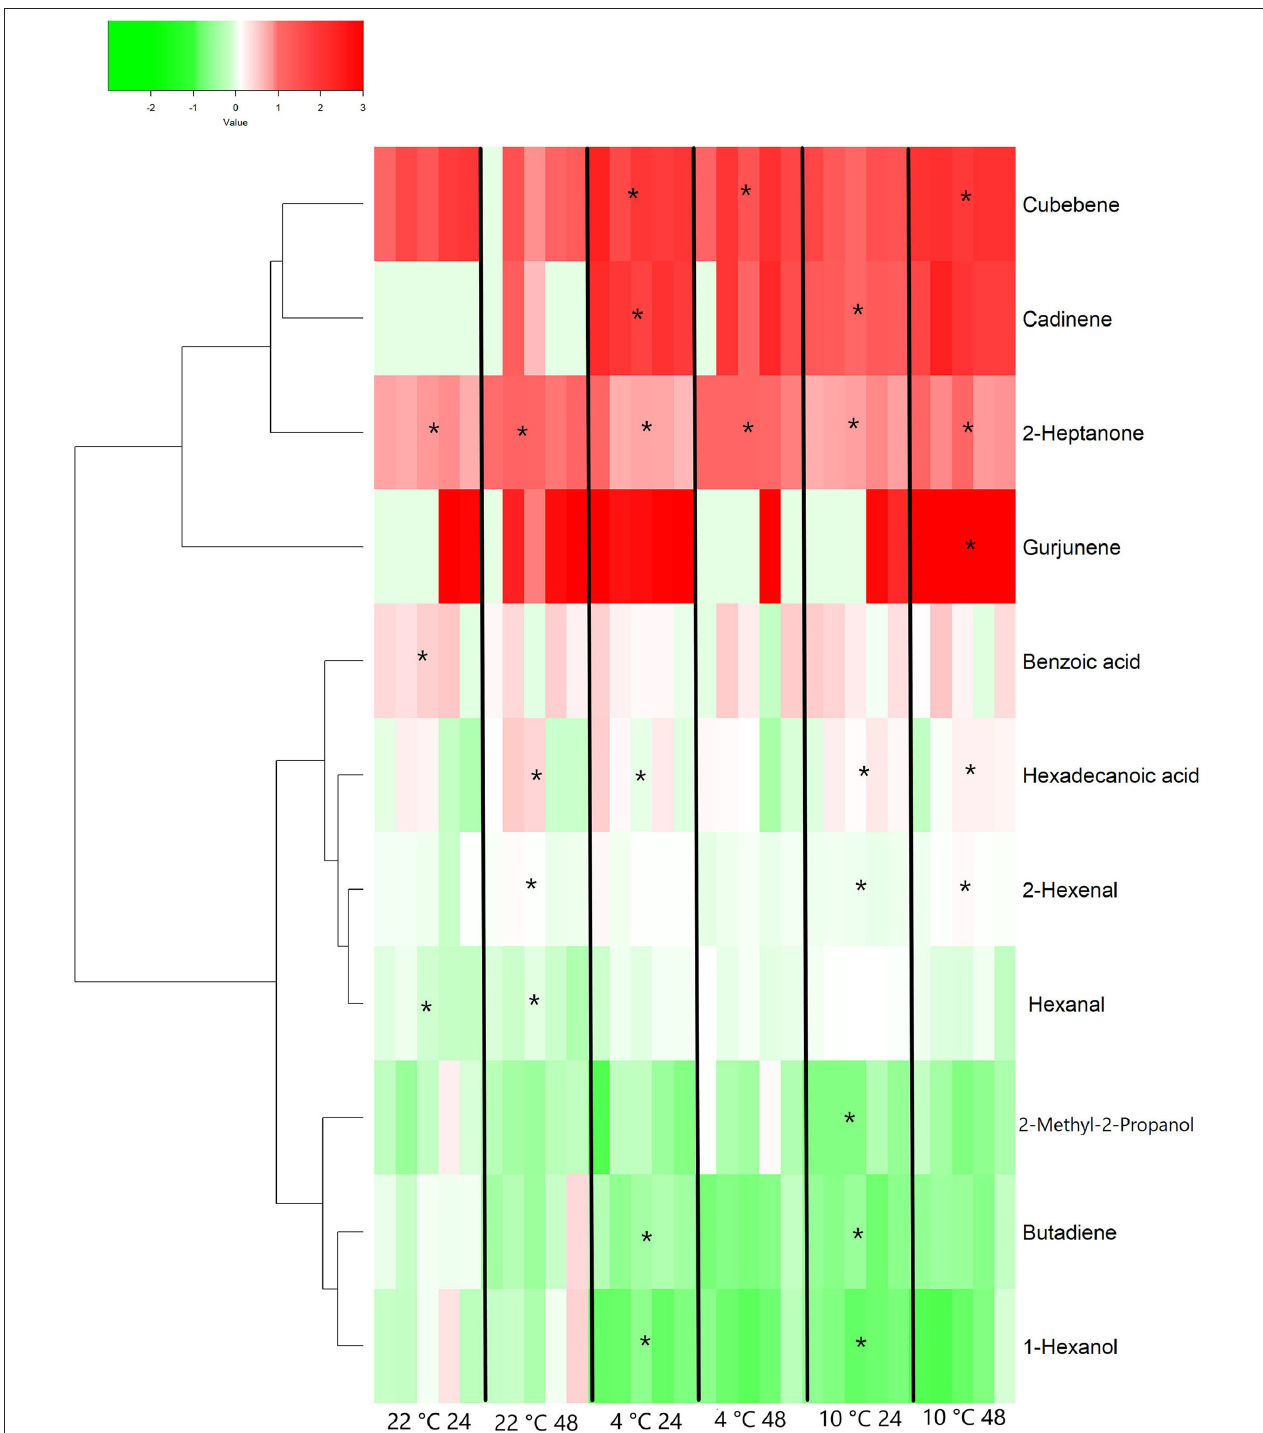
FIGURE 2 | Heatmap and Hierarchical Cluster Analysis performed on volatile organic compounds (VOCs) measured in Vermentino grapes following cooling treatment at 4 and 10 ◦ C for 24 and 48h and in control grapes at 22 ◦ C at the same sampling times. The heatmap shows the fold change of identified VOCs. Each cell represents the level of each compound in each of the five biological replicates for the specific postharvest condition, normalized to its level at harvest (T0) and transformed in logarithmic scale as following: log 2 (FC) = log 2 [replicate/mean(T0)]. A Pearson correlation coefficient was employed in order to group the different features, using average as clustering algorithm. Asterisks represent statistically significant differences compared to T0 samples (based on ANOVA and Tukey post-hoc test with p ≤ 0.05 performed separately for each sampling times).